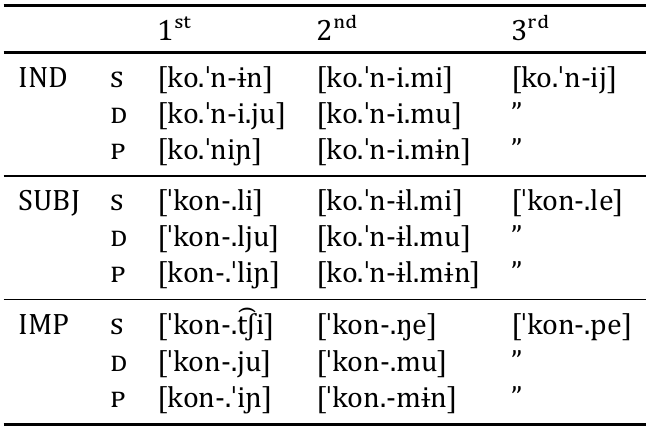
Table 5: PDM verbal paradigm for the consonant-(cid:976)inal root [kon-]